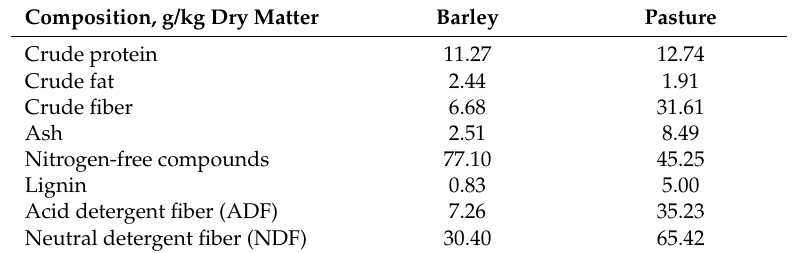
Table 1. Chemical composition of the pasture and barley supplemented to the